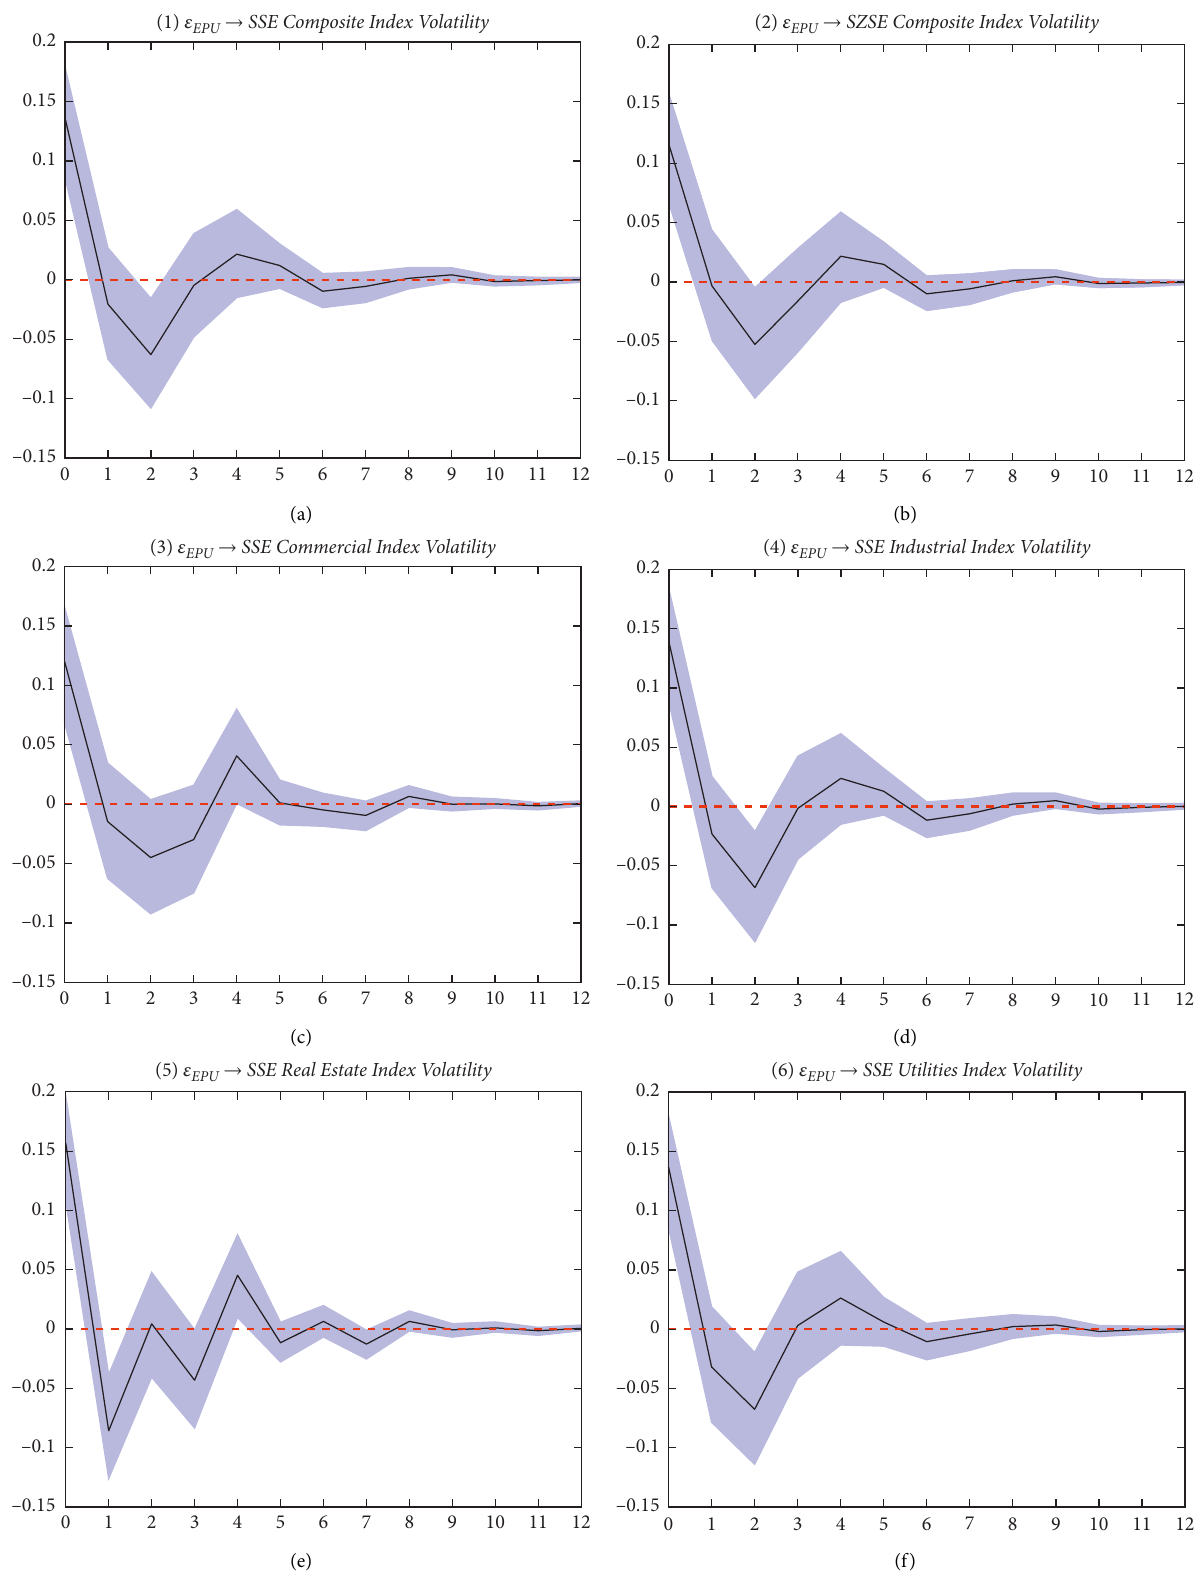
Figure 6: Impulse response of different stock market volatility to EPU shocks. Note: the solid black lines denote the median impulse response. The light-colored region denotes 68% error bands. Each period is a